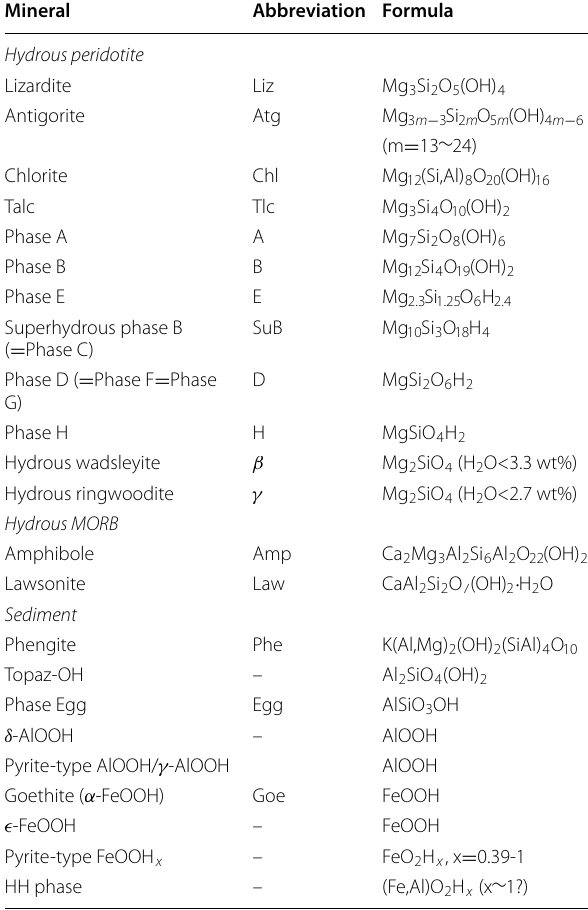
Table 1 Hydrous minerals, dense hydrous magnesium silicates (DHMSs), and nominally anhydrous minerals (NAMs) which could potentially exist in subducting oceanic plates Schmidt and Poli (1998); Inoue (2000); Ono (1998); Ohtani et al. (2001b). All Mg atoms can be replaced with Fe atoms in the chemical formula shown